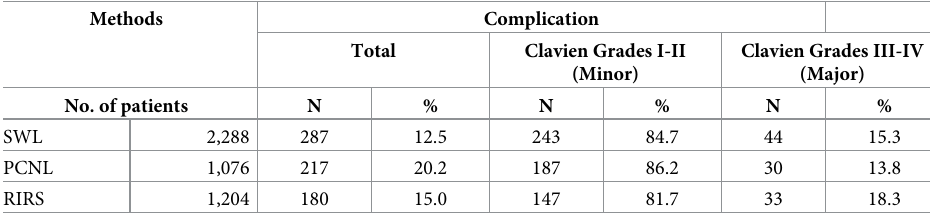
Table 3. Complication rates from studies according to Clavien-Dindo